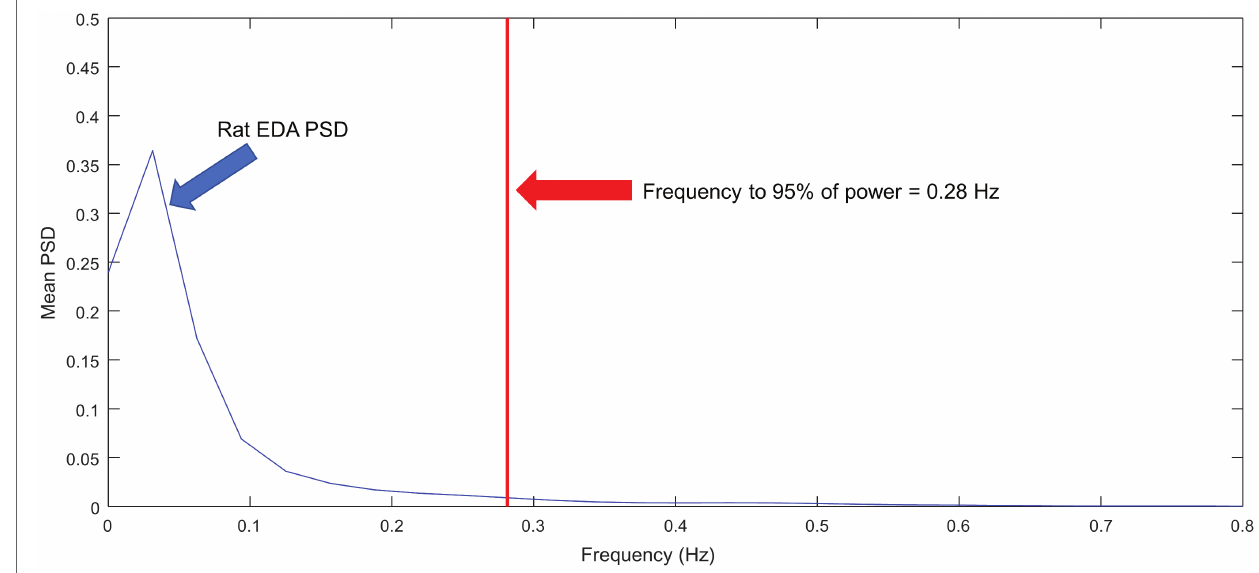
FIGURE 9 | Ensemble of normalized power spectral densities of EDA signals for N = 10 rats.